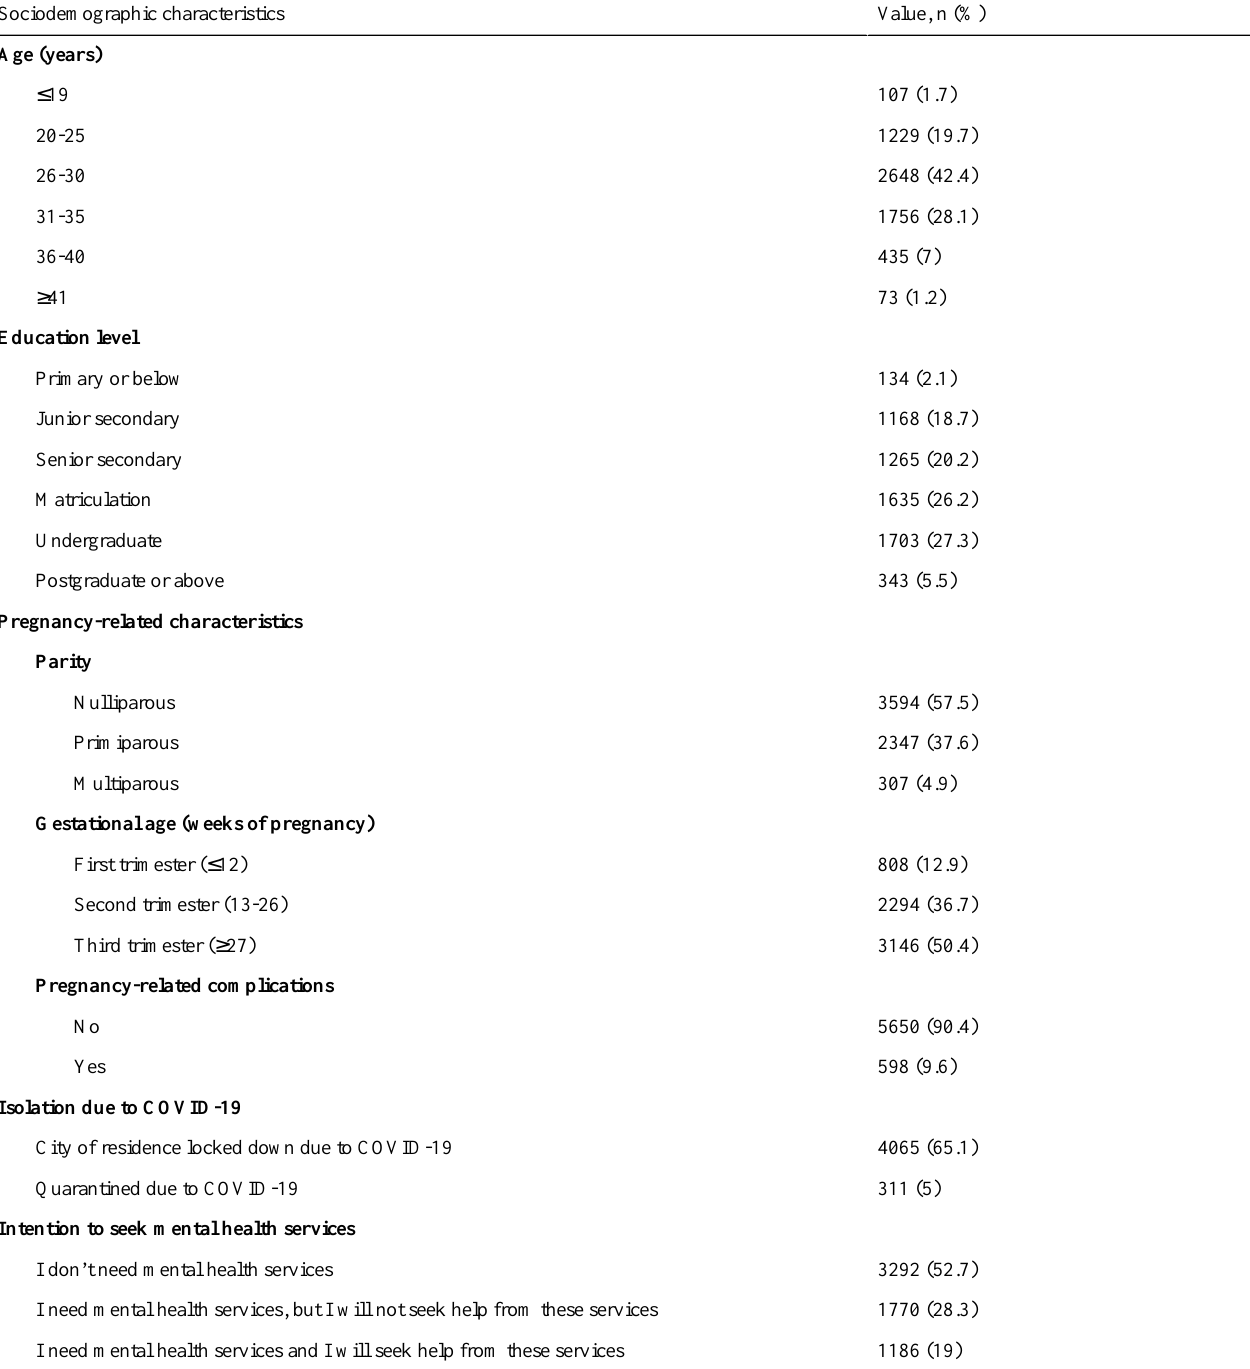
Table 1. Descriptive statistics of the participants